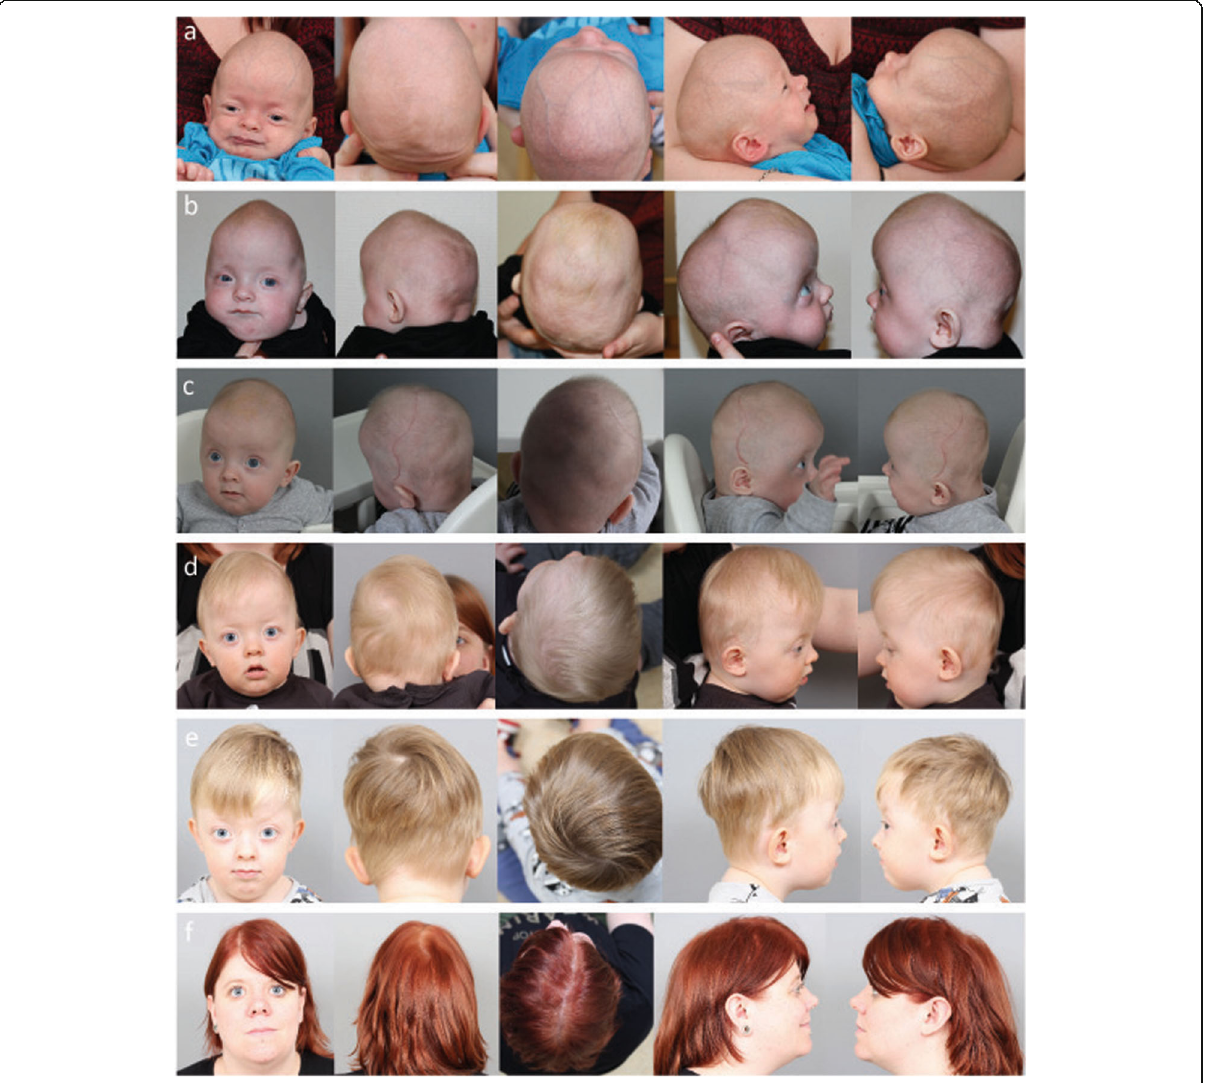
Fig. 1 Craniofacial features of the index patient presenting with bilateral lambdoid and sagittal synostosis ( a - e ). Mother of the index patient ( f ). ( a ) First visit at the age of seven weeks and two days. Constriction of the posterior skull, with a compensatory forehead expansion, and slight hypertelorism ( b ) The forehead expansion was more pronounced before operation at the age of 5 months. ( c ) After operation at the age of 6 months. Note brachycephalic head shape, and mild exorbitism ( d ) After operation at the age of 13 months. Note brachycephalic head shape, and more pronounced exorbitism ( e ) Index patient at the age of 3 years and 6 months. Note a normal head shape, and even more pronounced exorbitism ( f ) Mother of the index patient at the age of 26 years, operated for a sagittal synostosis at the age of 5 years. Note a